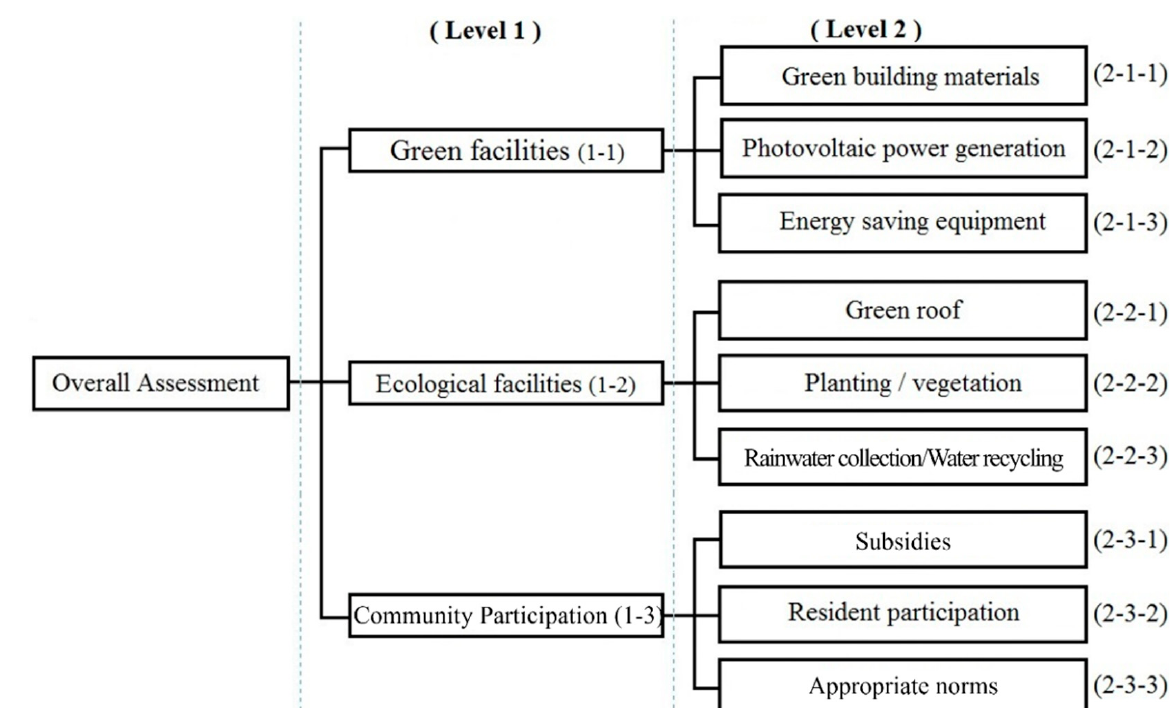
Figure 2. AHP hierarchy diagram in this study.